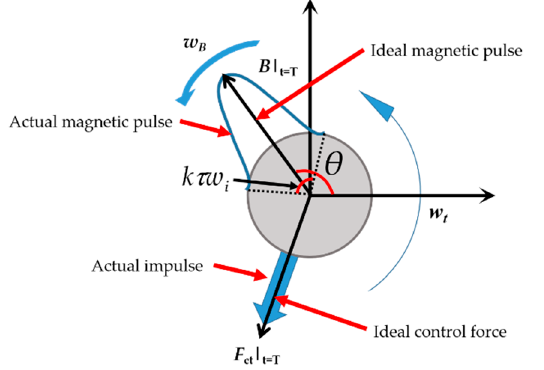
Figure 7. Magnetic pulse.